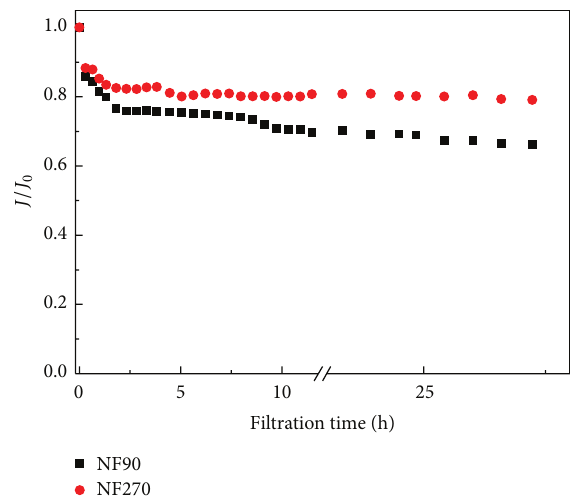
Figure 3: Normalized permeate flux of NF270 and NF90 mem- branes (applied pressure: 500 kPa; concentration of humic acid: 50 mg L −1